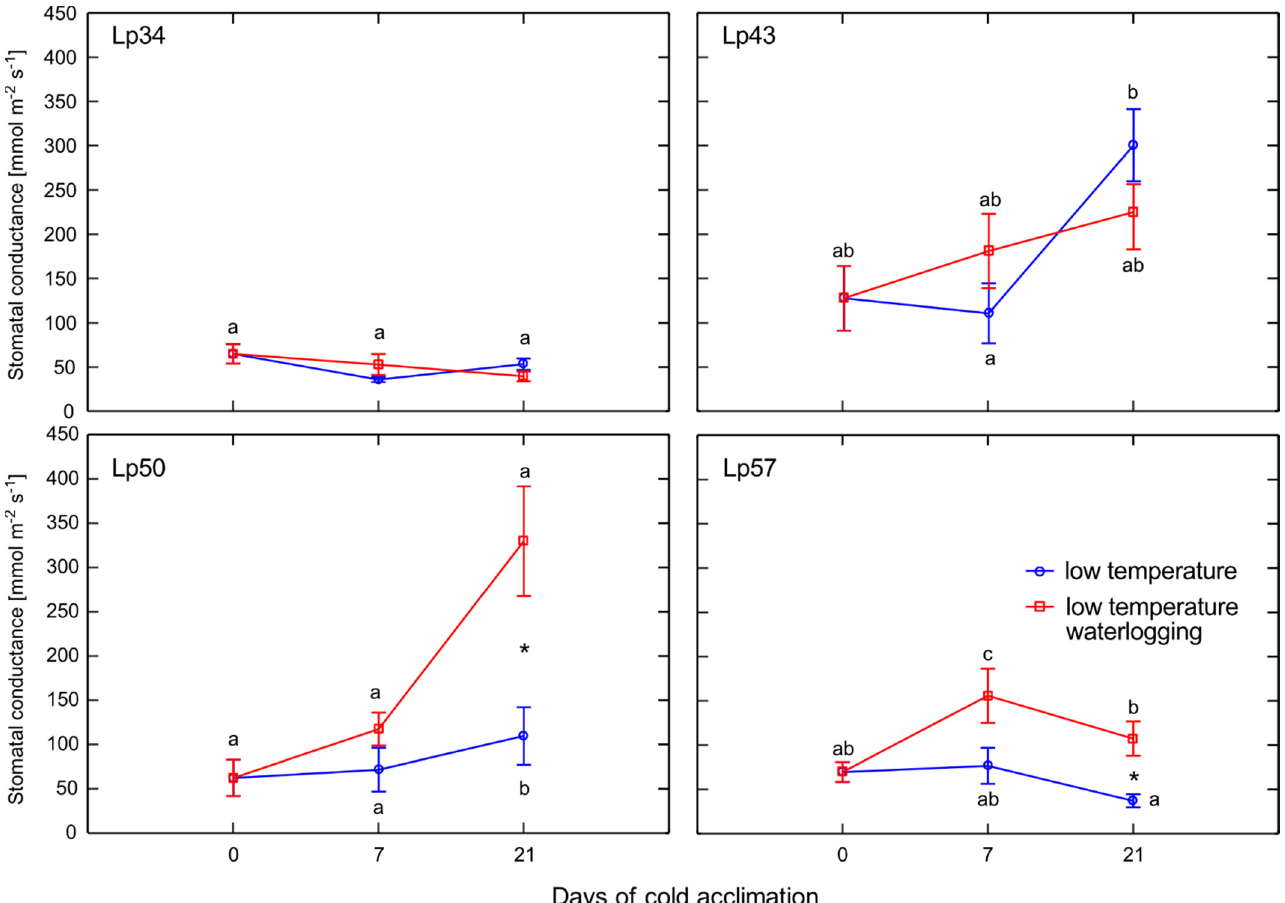
Figure 3. Stomatal conductance of cold-acclimated Lolium perenne genotypes. Four genotypes (Lp34, Lp43, Lp50, and Lp57) were tested. The results are means ( n = 9), error bars indicate the standard error. Asterisks indicate means that differ significantly between waterlogged and control plants according to one-way ANOVA (p < 0.05). Different lower-case letters indicate means that are statistically different according to Duncan’s multiple range test ( p < 0.05).